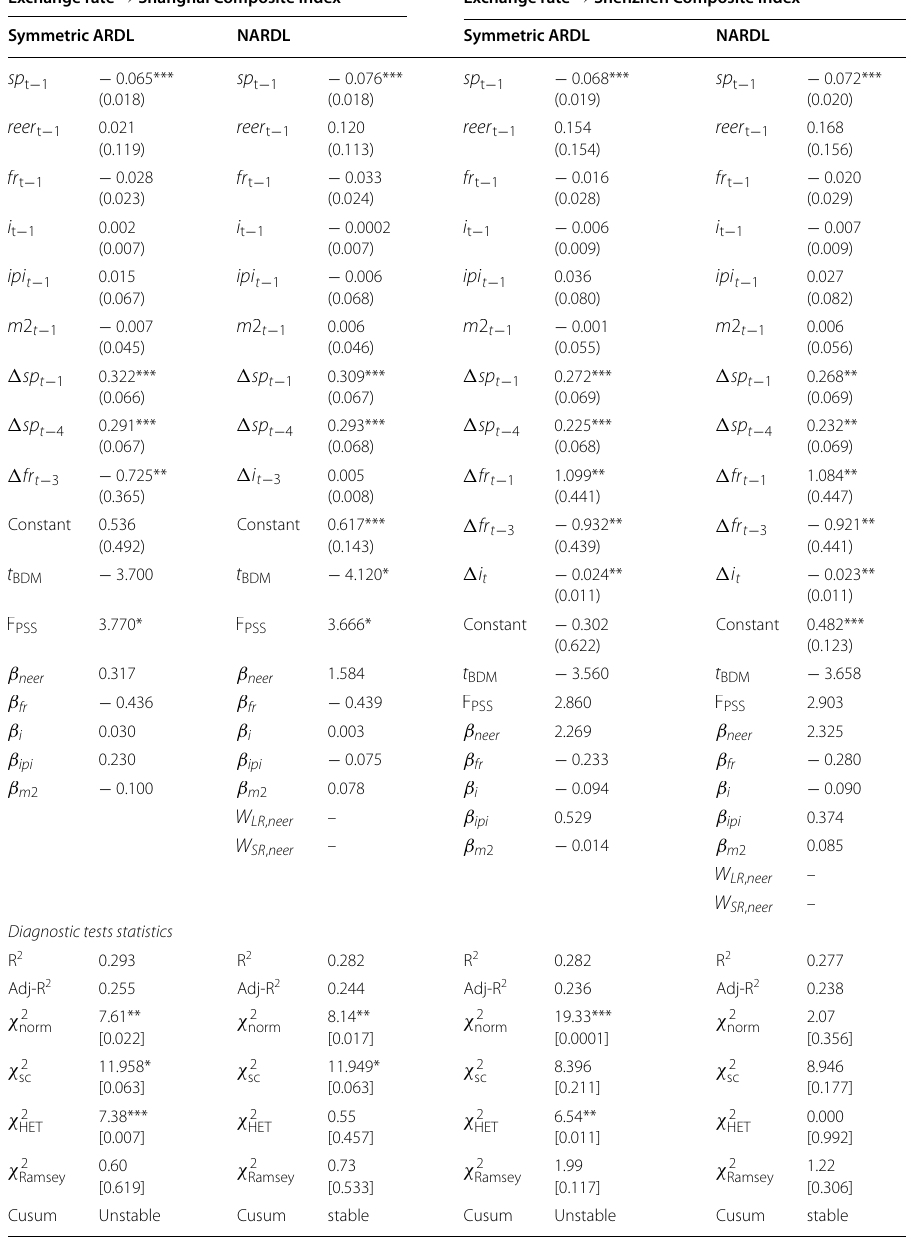
Table 2 Symmetric and asymmetric estimation results for exchange rates pass through to stock